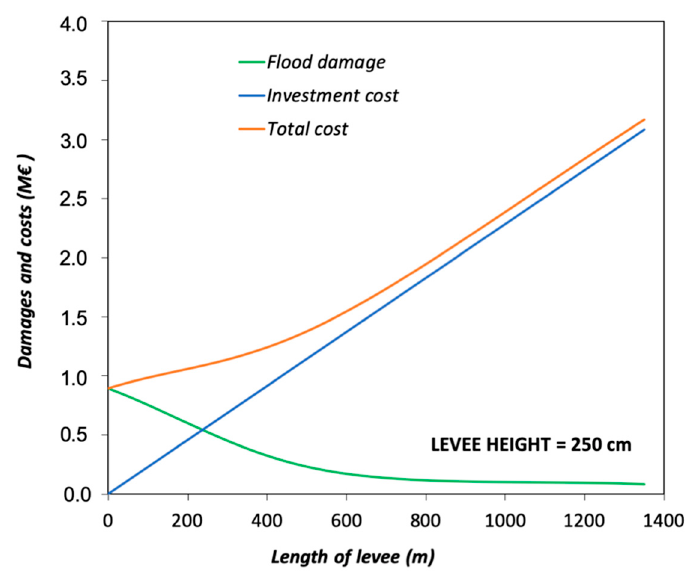
Figure 12. Cost–benefit analysis for scenario 1.